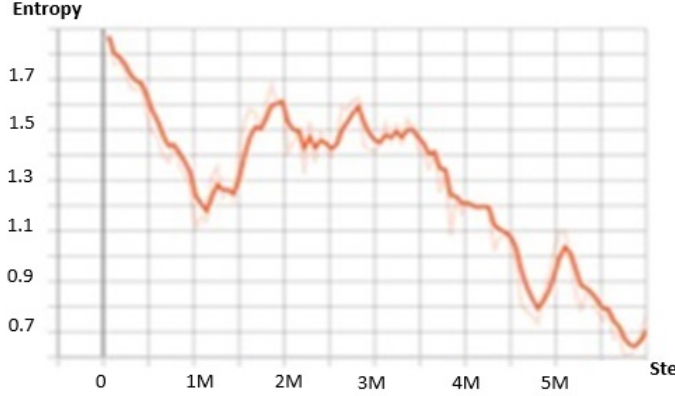
Figure 5. Evolution of the entropy during the training (scenario 4).